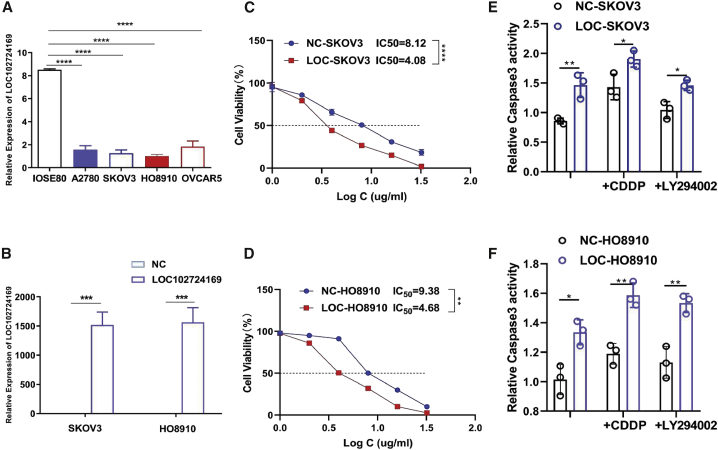
LOC102724169 was necessary for reducing cell viability and inducing apoptosis of EOC cells(A) Relative expression of LOC102724169 was tested in EOC cell lines (A2780, SKOV3, HO8910, OVCAR5) and the normal ovarian cell line (IOSE80) using qRT-PCR assays. (B) Relative LOC102724169 expression was tested in SKOV3 and HO8910 cells transfected with LOC102724169 transcript or negative control using qRT-PCR assays. (C and D) IC50 of SKOV3 and HO8910 cells transfected with LOC102724169 transcript was determined by CCK-8 assays using a wide range of cisplatin concentrations. (E and F) Caspase-3 activity assays indicated the expression of caspase-3 among different groups in both SKOV3 and HO8910 cells. ∗p < 0.05, ∗∗p < 0.01, ∗∗∗p < 0.001, ∗∗∗∗p < 0.0001. Data are represented as mean ± SEM.